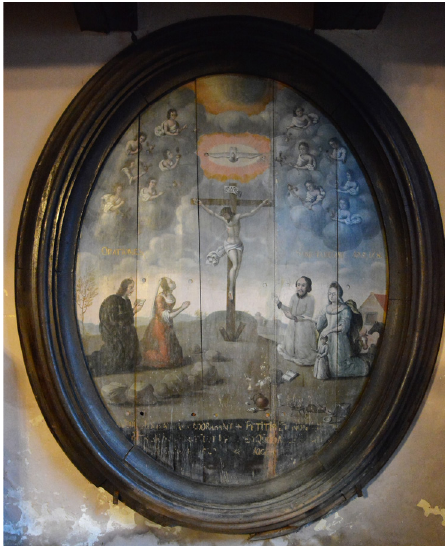
Figure 11 The right and wrong pray.